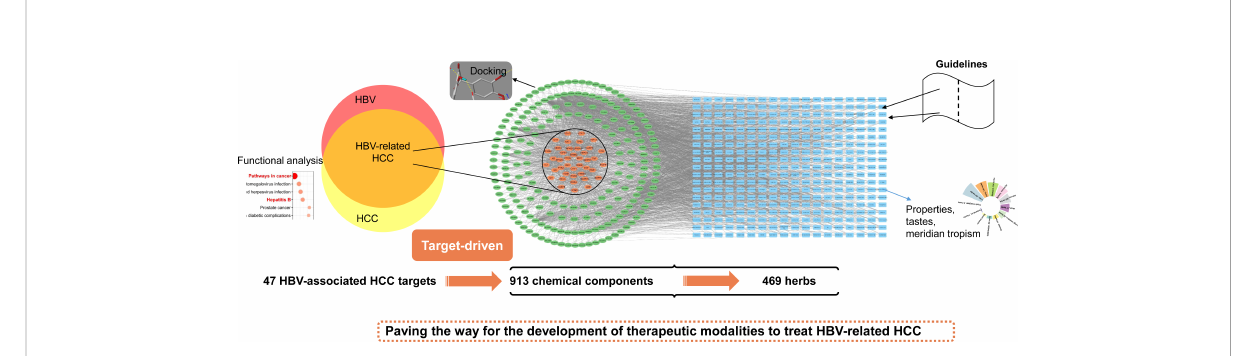
FIGURE 1 Work fl ow of this